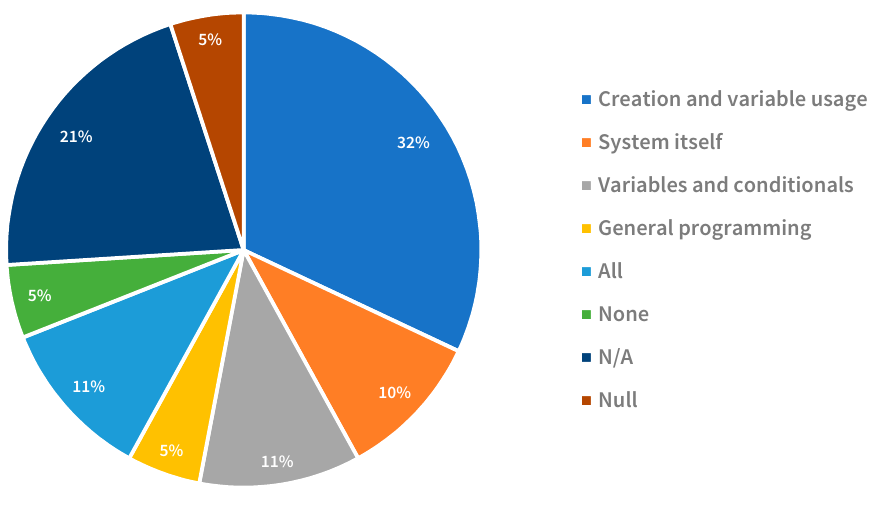
Figure 5. Open comments summary of the students about Prof. Watson